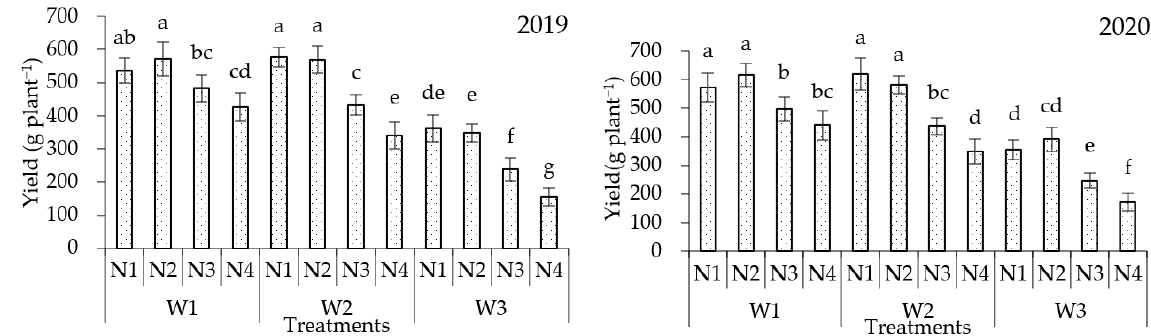
Figure 2. The yields of the green peppers in 2019 and 2020. Bars stand for standard error of the mean difference. Different small letters above the bars indicate a significant difference for various water levels and N treatments at p < 0.05 according to an LSD test within same year.